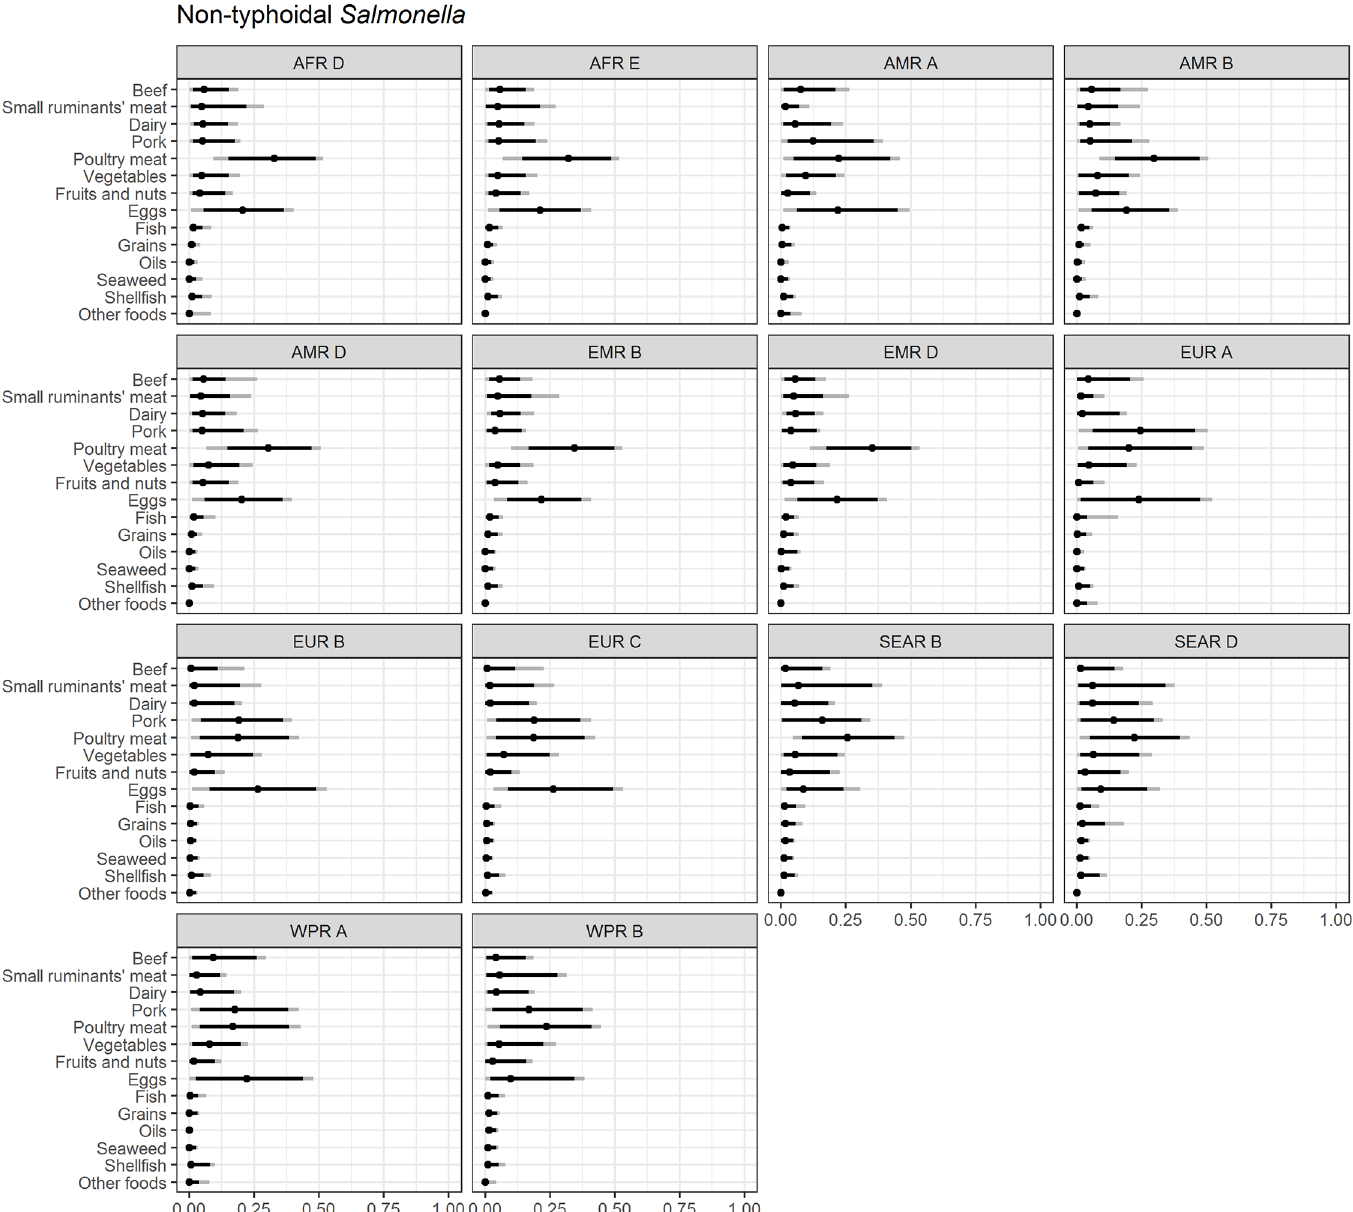
Fig 13. Non-typhoidal Salmonella spp. Proportion of foodborne disease attributable to specific foods: Median estimate, and 90% and 95% uncertainty intervals by bacteria and subregion. “Small ruminants’ meat” was listed as “Goat, lamb and other small ruminants’ meat” in the expert elicitation instrument. The X-axis labelsare percentages. The dot represents the medianestimate; the dark black line, the 90% uncertaintyinterval; and the gray line the 95% uncertaintyinterval.